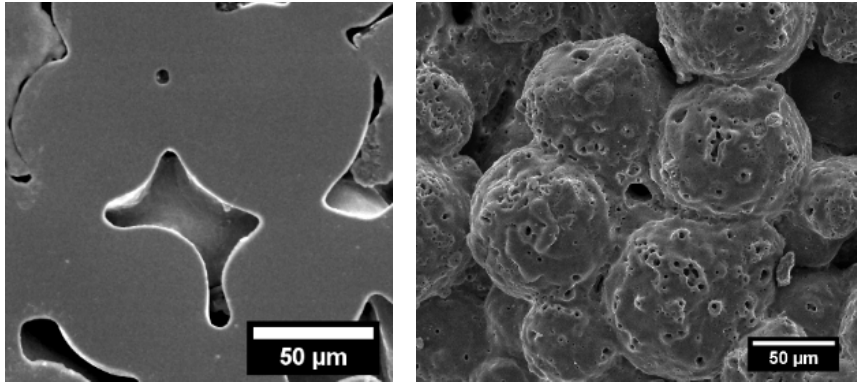
Figure 13. Images of the ground surface of a sample before PEO treatment showing four partially-sintered Ti particles and the surface of a specimen (without grinding) after being subjected to PEO.